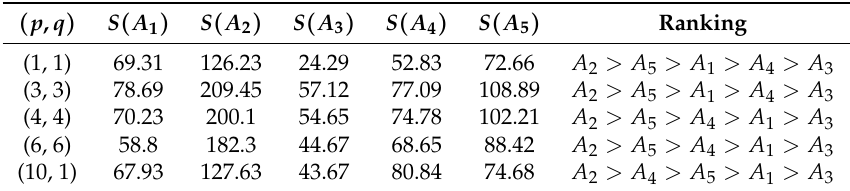
Table 9. Liu and Li’s method [6] (ranking for different parameters of the normal neutrosophic weighted Bonferroni mean (NNWBM)).